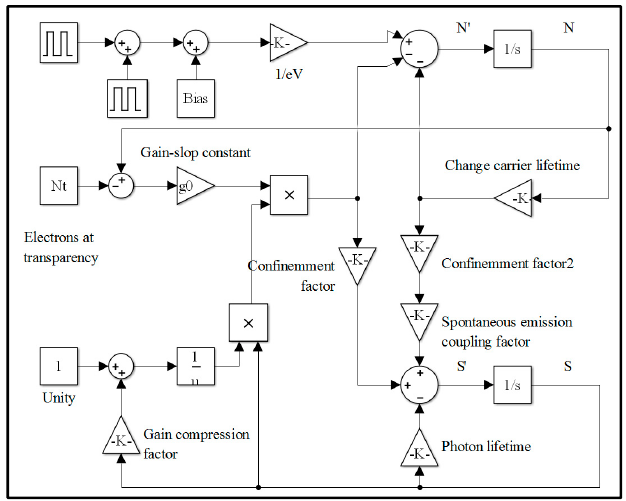
Figure 2. Block diagram of the step modulation for simulation in the semiconductor laser.